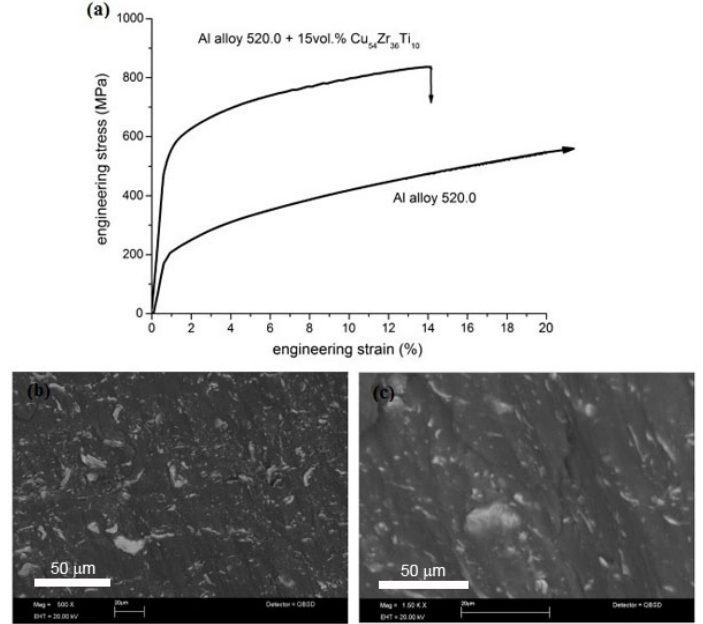
Figure 7. ( a ) Compression stress-strain curves and ( b , c ) fractographic evidences of 15 vol% Cu 54 Zr 36 Ti 10 glassy particle reinforced A520 alloy composite (reprinted from Dudina et al . 2010 [9], with permission from ©